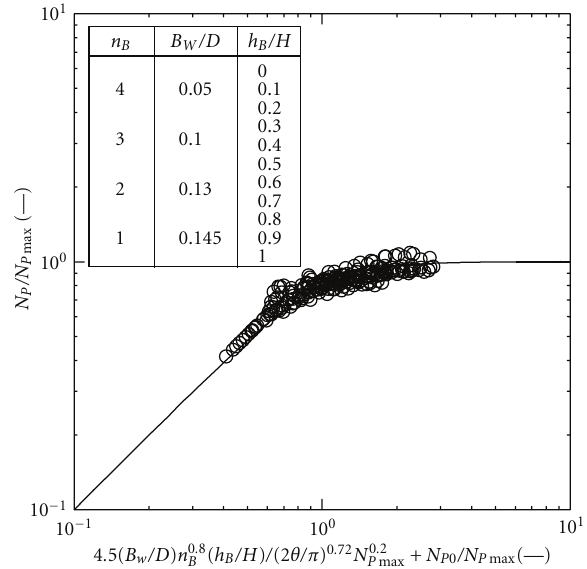
Figure 8: Power diagram of helical ribbon-impeller (— calc; (cid:2) N P 0 ).